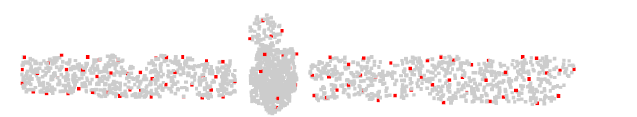
Figure 11. The ISS keypoint extraction result. The red points are the selected ISS